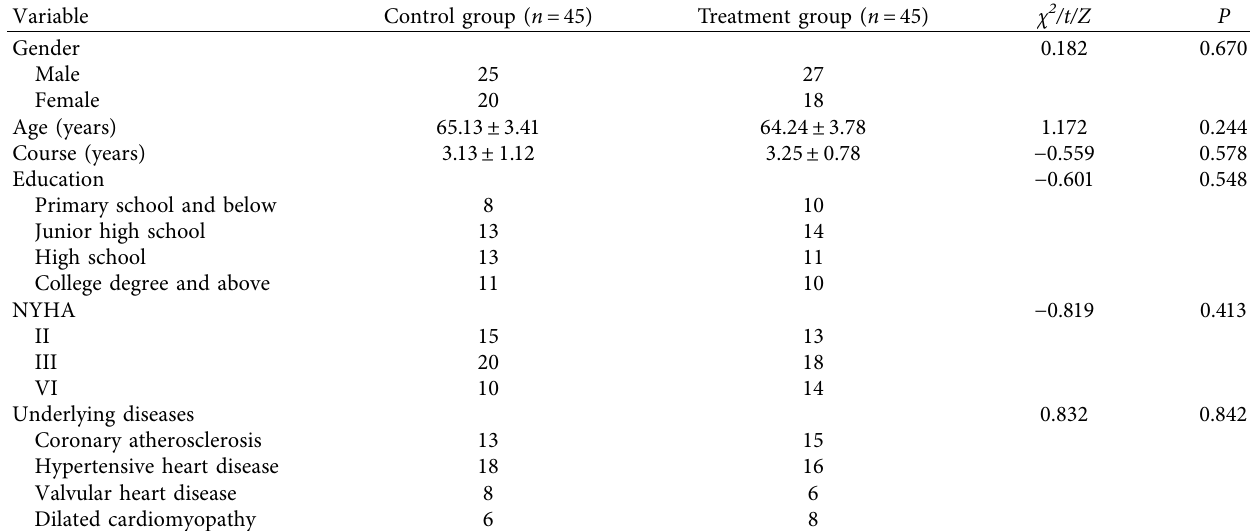
Table 1: Comparison of general data between the two